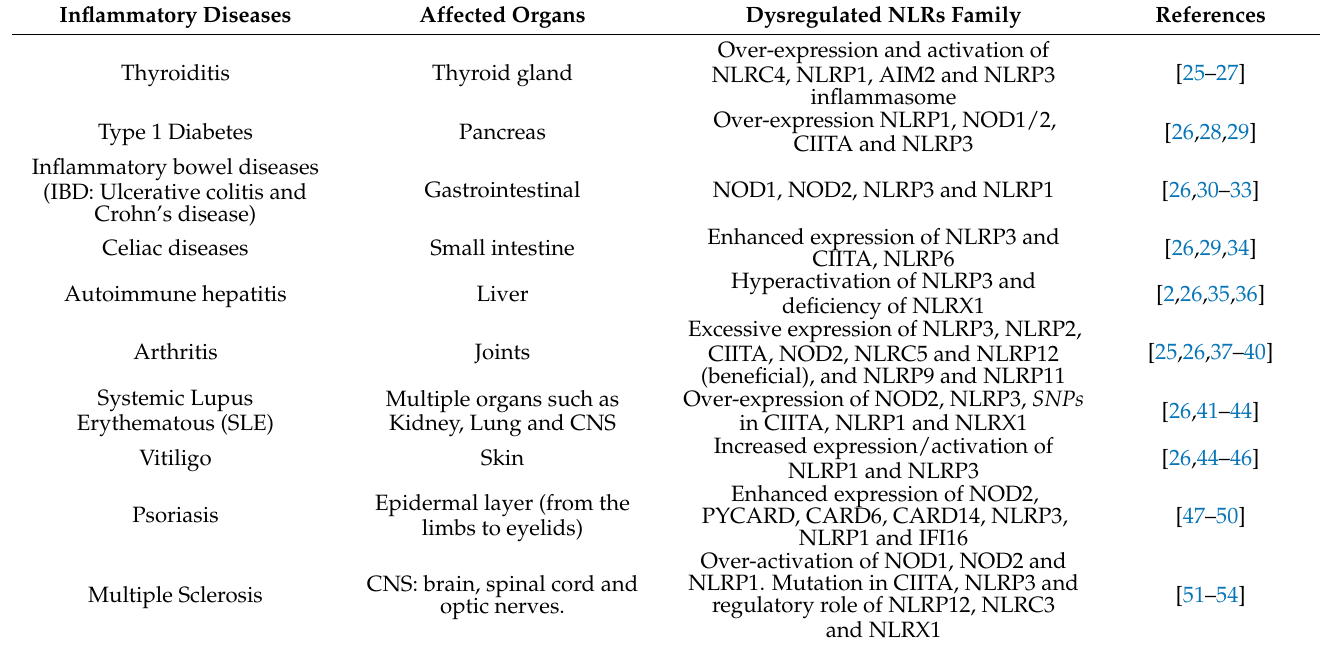
Table 1. Involvement of the NLRs family in chronic inflammatory diseases.